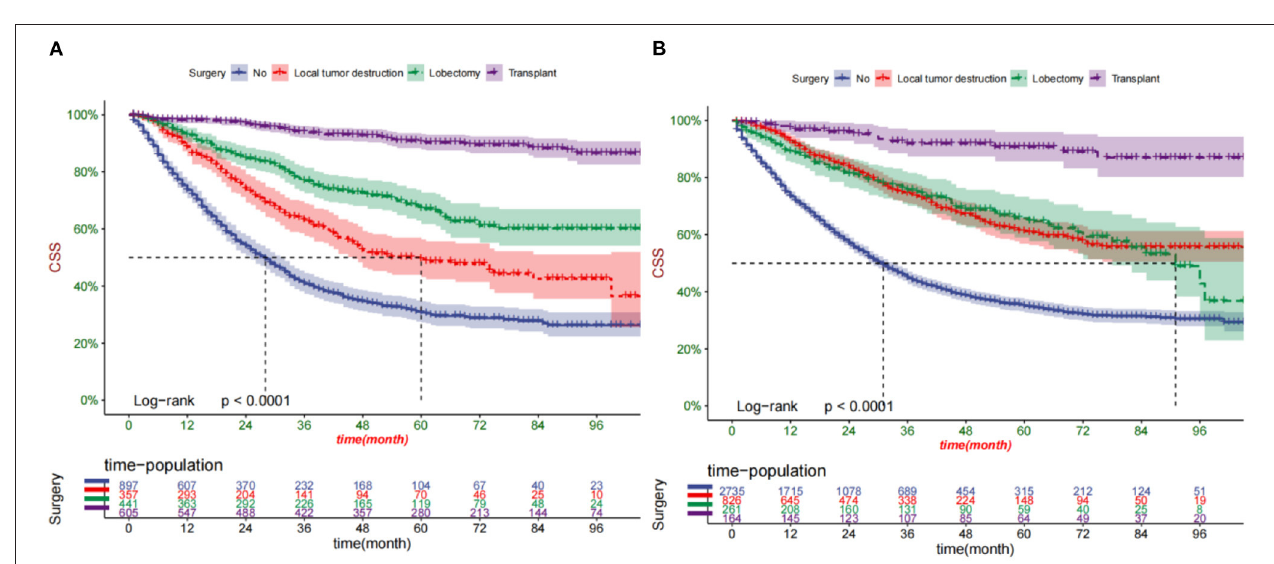
FIGURE 6 | Kaplan-Meier curves of patients in the low-risk and high-risk groups in training cohort (A) and validation cohort (B) .